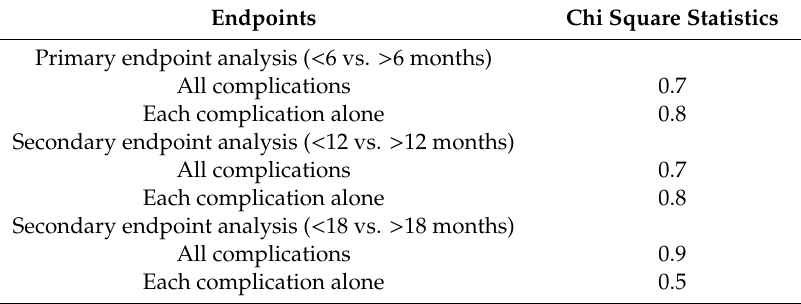
Table 3. Chi square statistics of biliary stent related